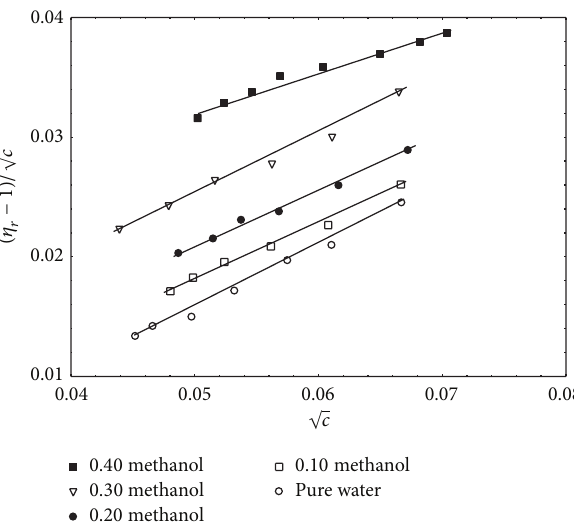
Figure 6: Variation of CMC with volume fraction of methanol of CTAB solution at different temperatures.